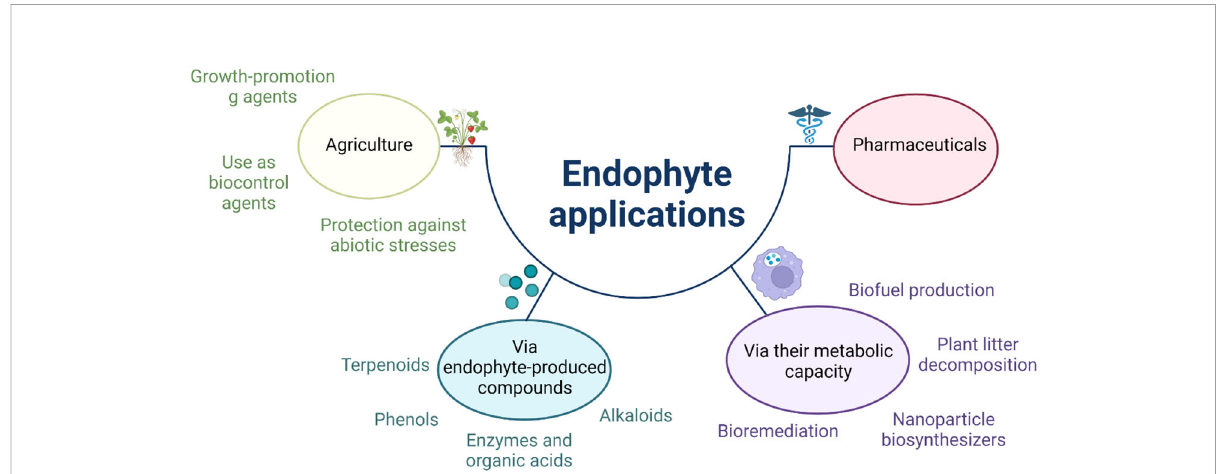
FIGURE 2 Schematic shows the fungal bioinoculants) applications in response to diverse stress